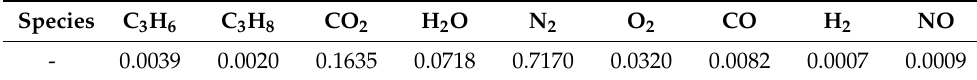
Table 3. Exhaust gases species concentrations: Mass fractions. Species C 3 H